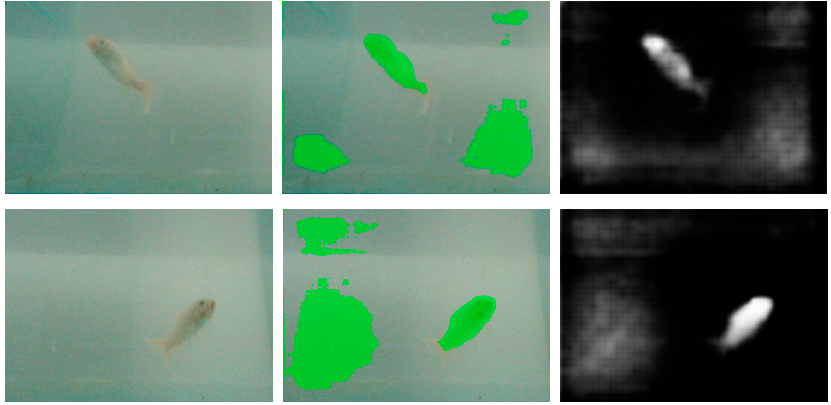
Figure 13. Results of the self-made data set on the model M1.